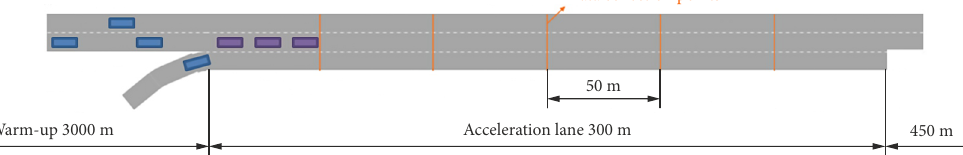
Figure 6. AdaptHdwy function